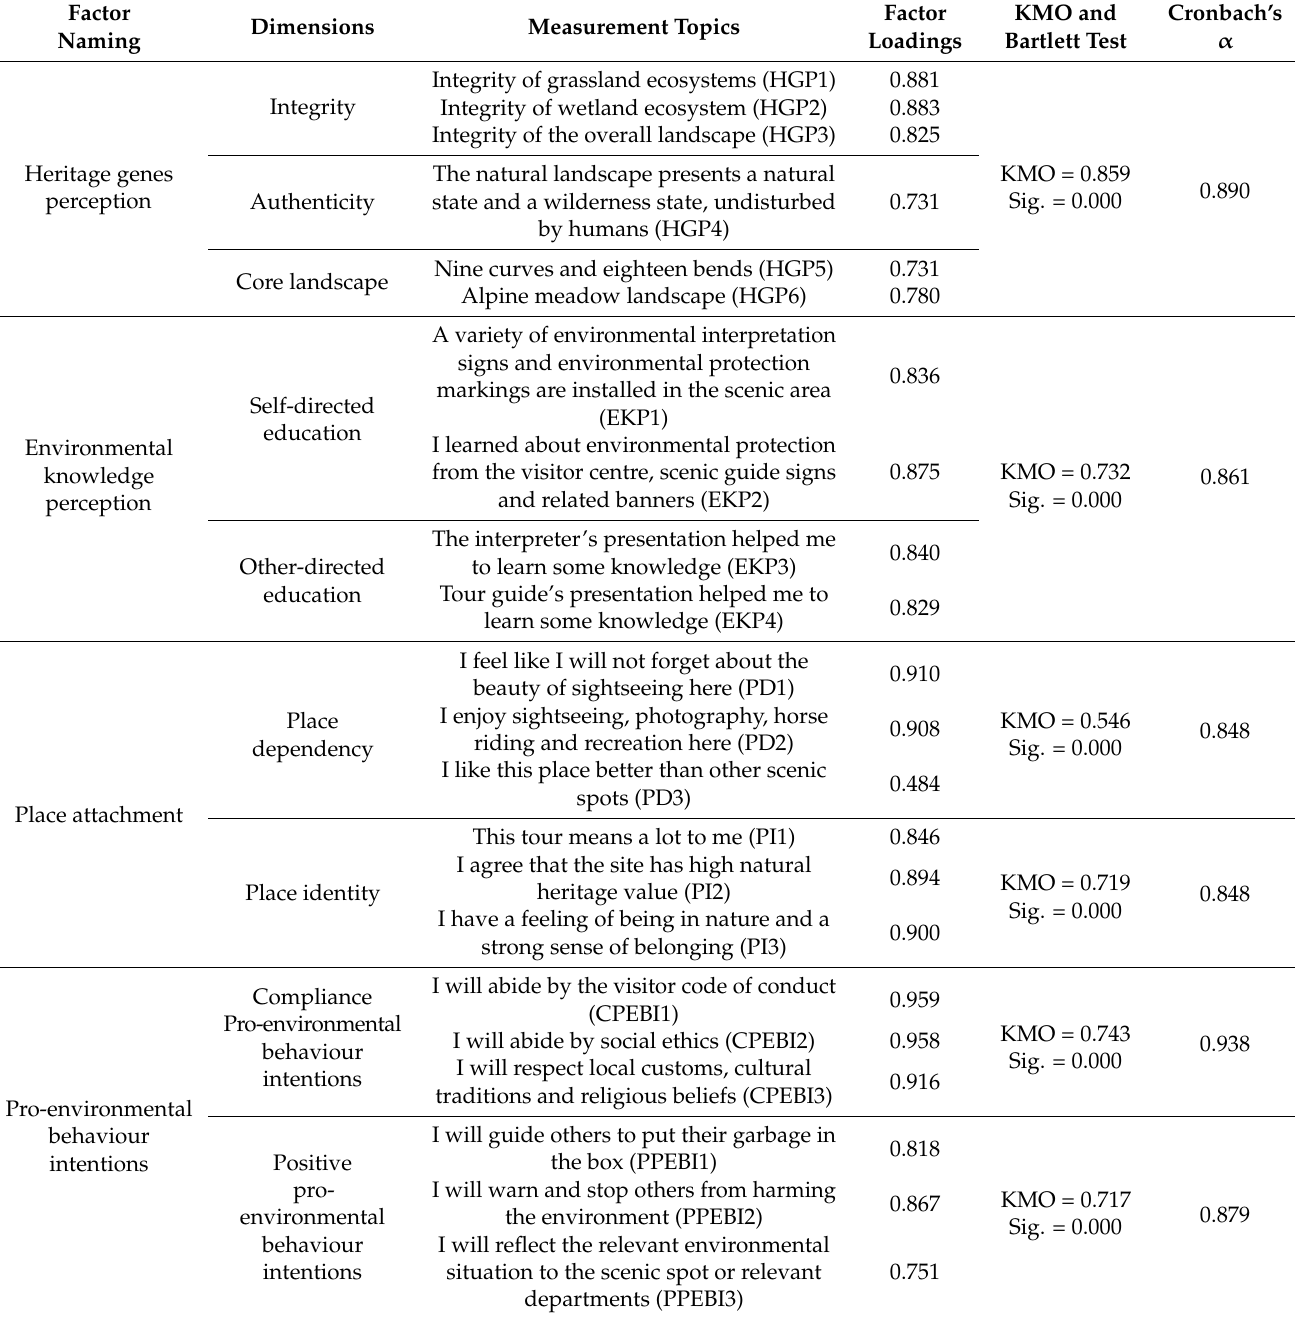
Table 3. Exploratory factor analysis of the measurement